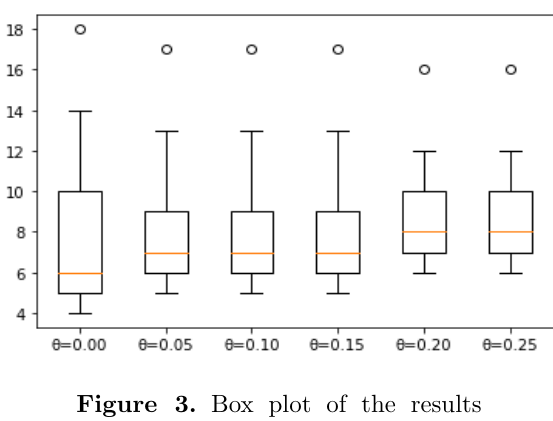
Figure 3. Box plot of the results for the Newsvendor Problem with Poisson(5) and R =